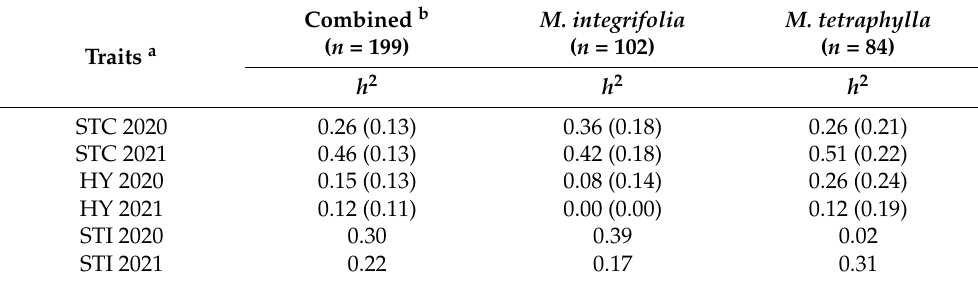
Table 4. Individual genomic narrow-sense ( h 2 ) heritabilities of traits, assessed in GWAS for three panels. Standard errors of count variable estimates are in brackets.